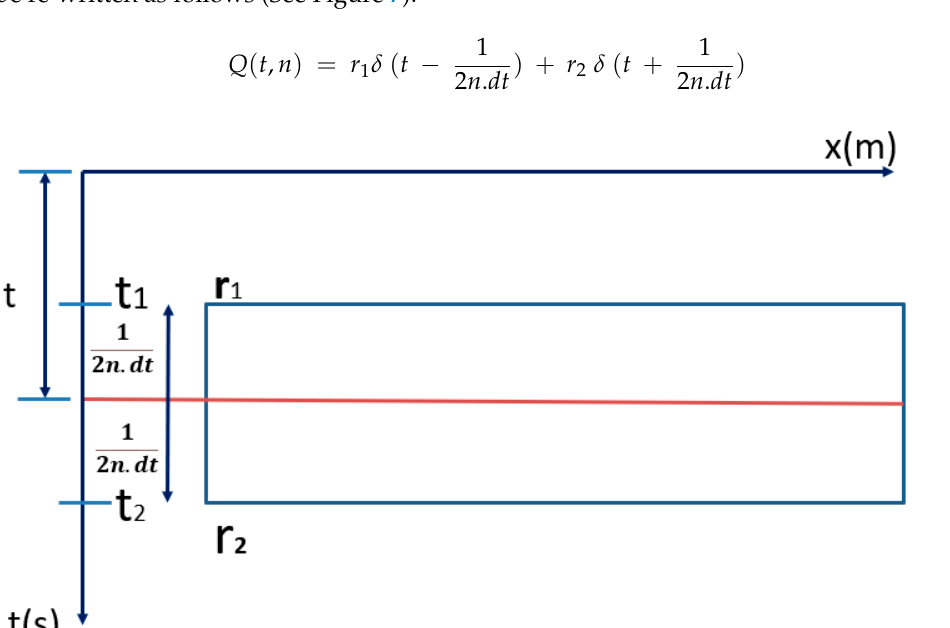
Figure 6. A two-layer reflectivity model.